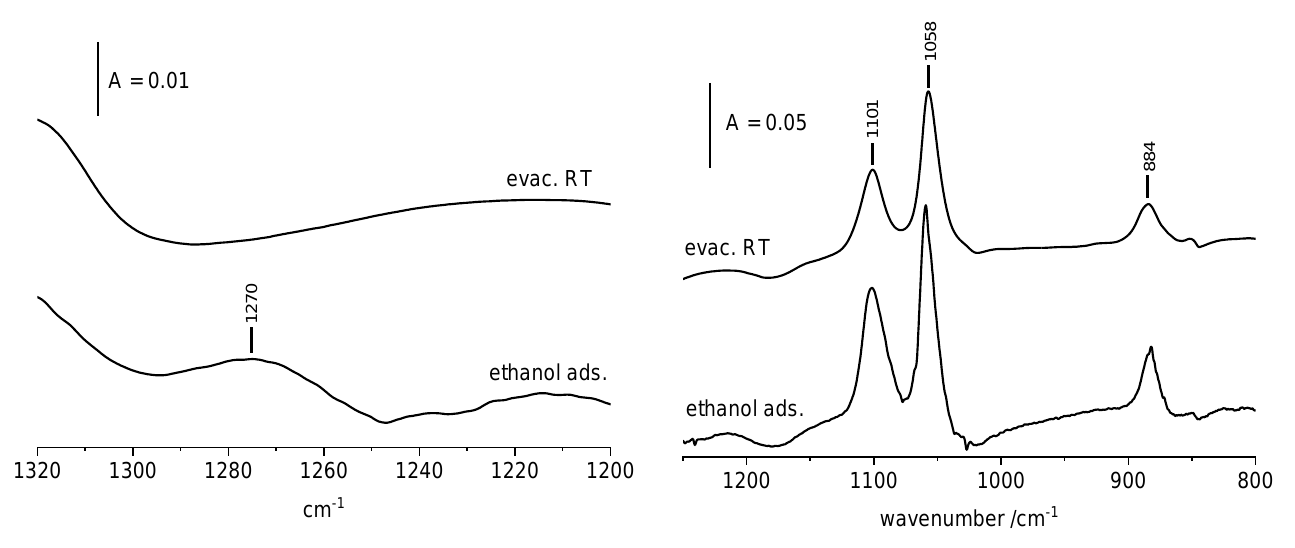
Figure 4. The spectra recorded upon the adsorption of ethanol (ca. 15 Tr. in gas phase) on CuO and evacuation at RT. The spectrum of gaseous ethanol was subtracted.